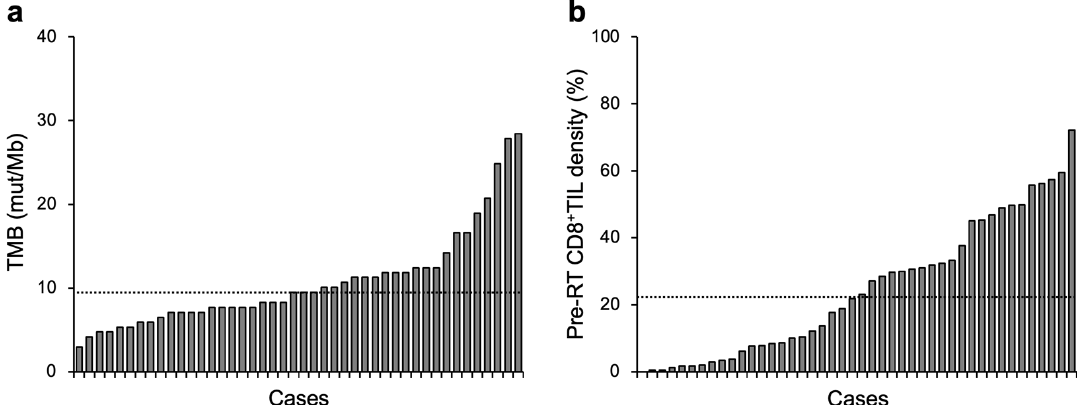
Figure 1. Overview of TMB ( a ) or pre-RT CD8 + TIL density ( b ) in patients with cervical cancer treated with definitive radiotherapy ( n = 44). Dashed lines indicate median values: 9.5 mut/Mb and 22.5% for TMB and pre-RT CD8 + TIL density, respectively.